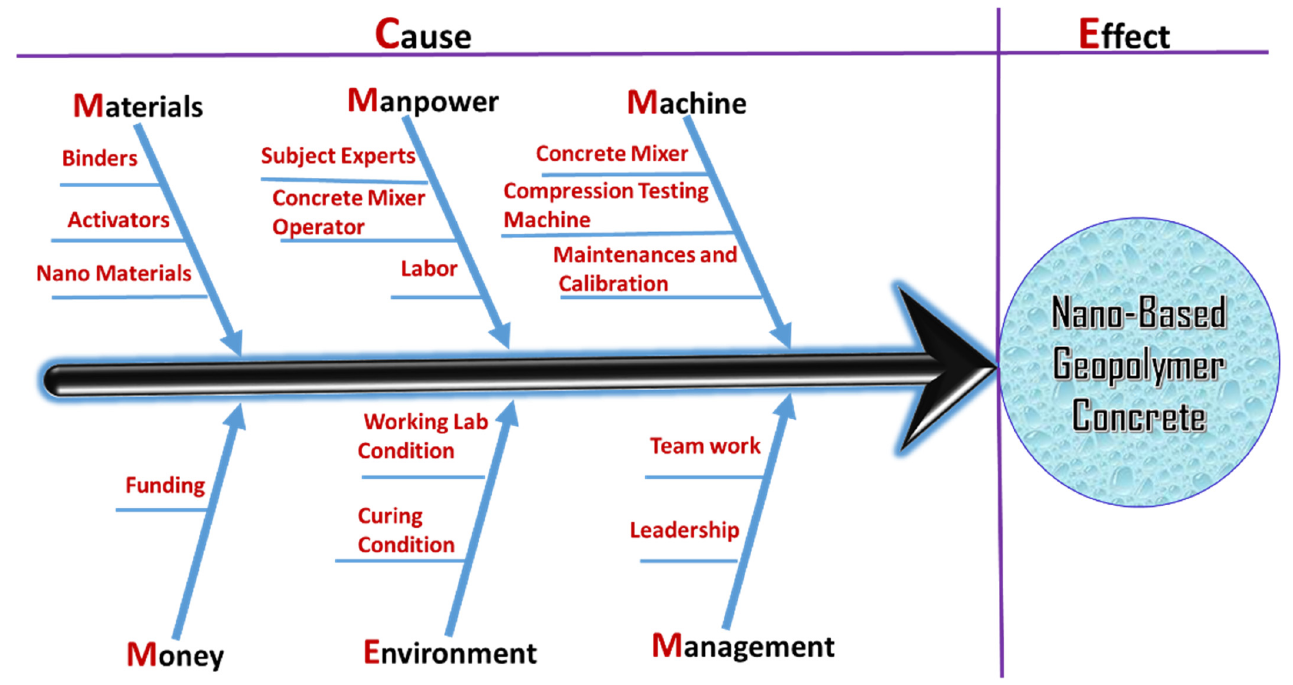
Figure 13. Ishikawa cause-and-effect diagram of GPC.